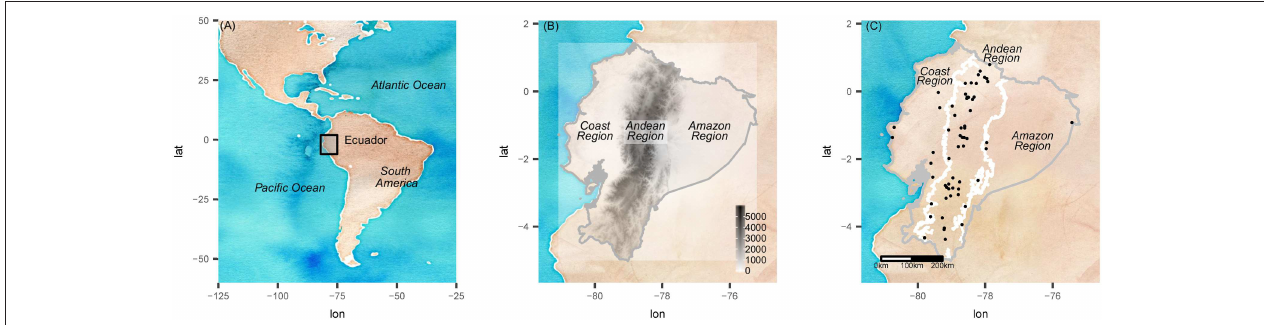
FIGURE 1 | Study area. (A) Ecuador is located in South America (left). (B) The Highlands are a weather divide between the coast and the Amazon (center). (C) Ground rainfall stations (black points) used for this study (right). Due to logistical limitation very few stations are located in the Amazon.